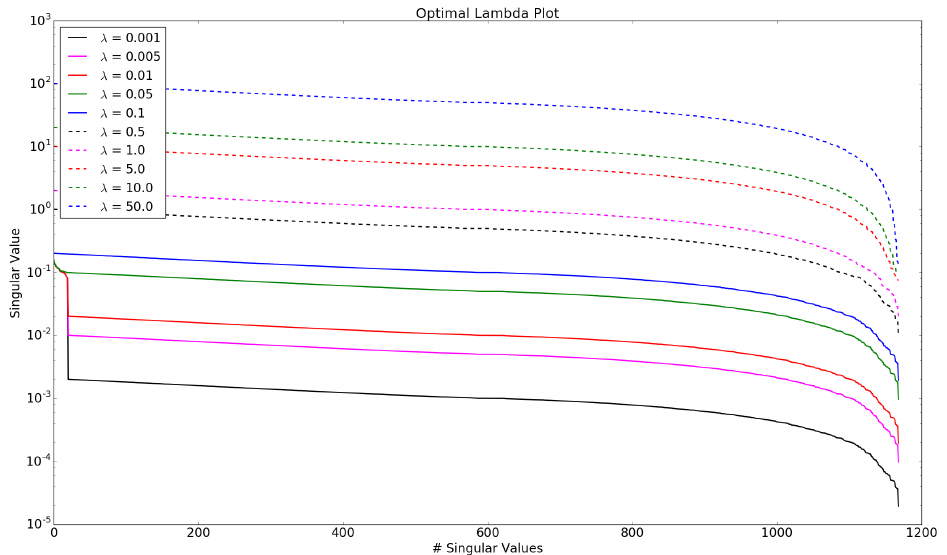
Figure 5. Variation of regularization weight parameter λ